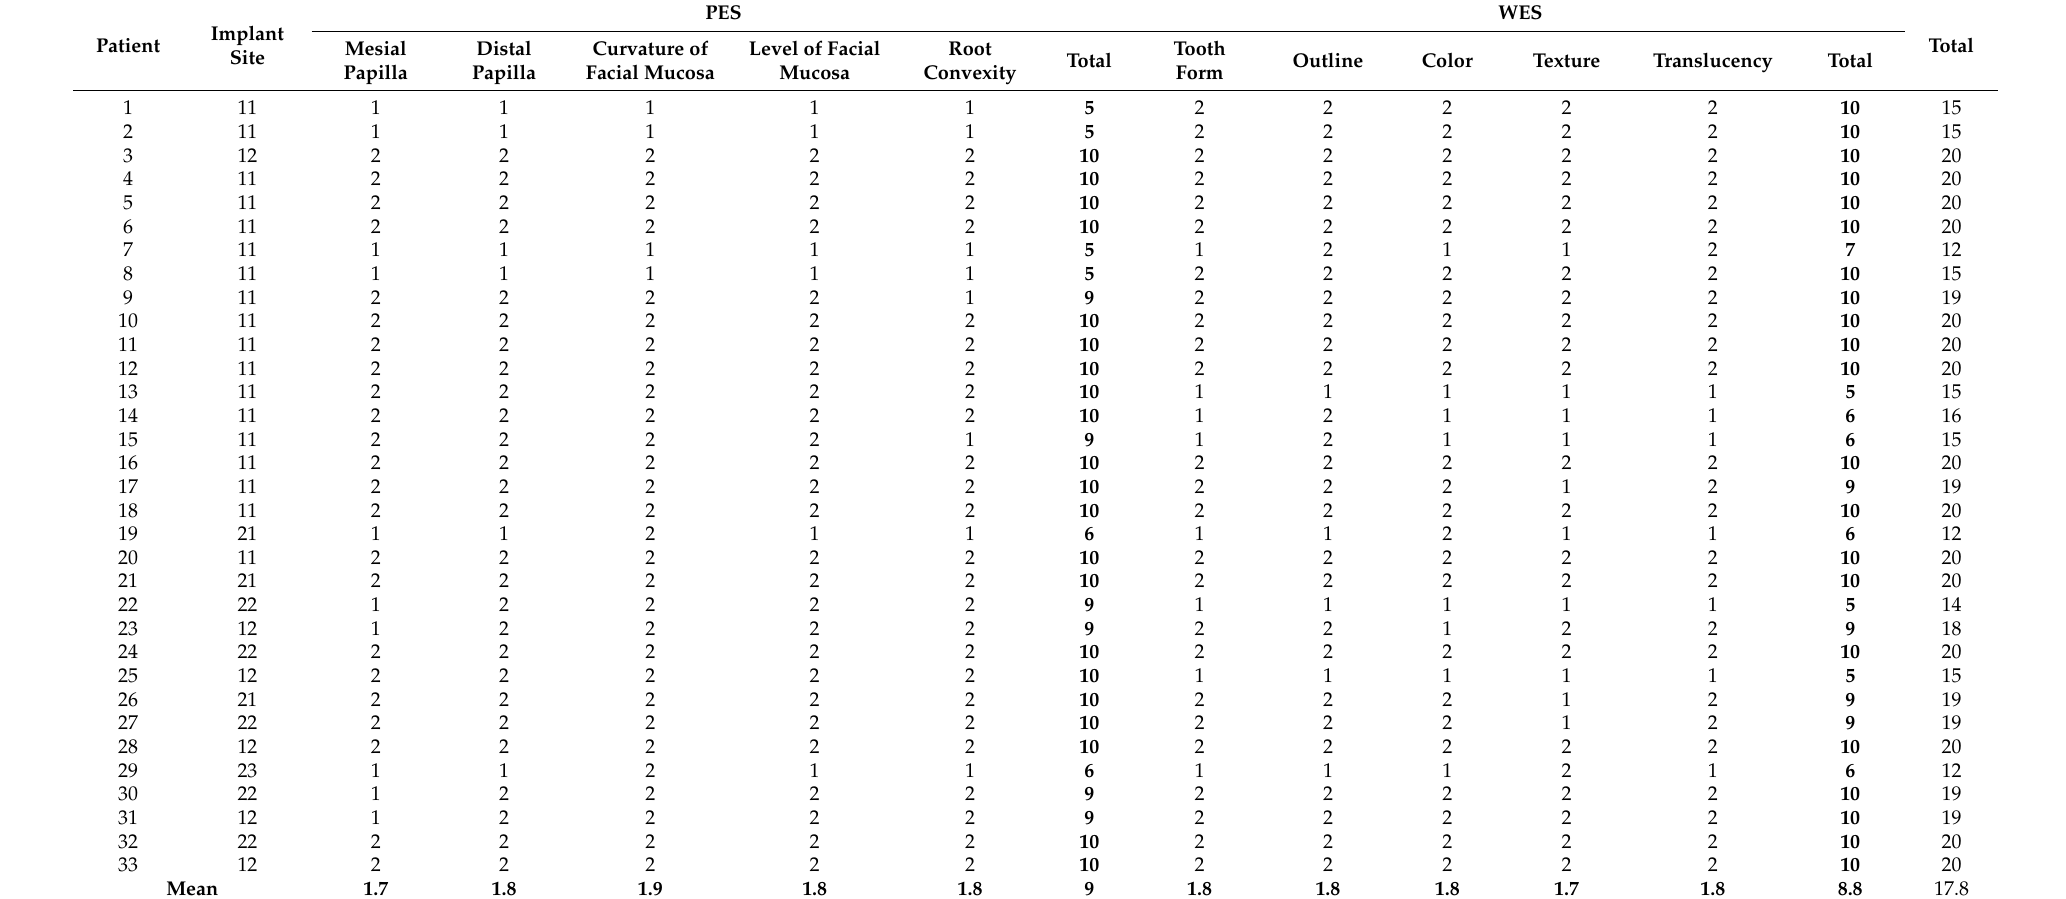
Table 1. Detailed PES and WES values of all